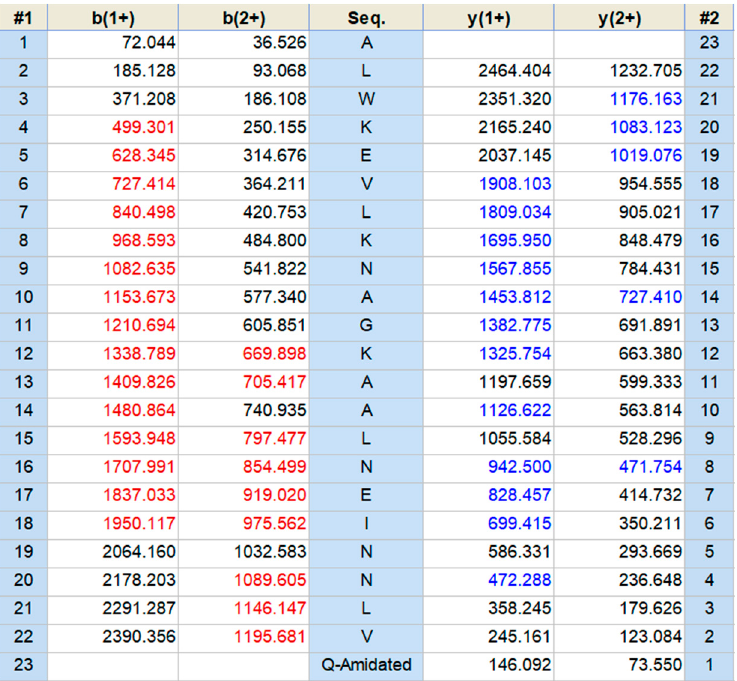
Figure 5. MS/MS fragmentation datasets derived from ions coincident with the mass of Dermaseptin-PH. Predicted singly and doubly charged b -ions and y -ions arising from MS/MS fragmentation of Dermaseptin-PH. Ions detected by MS/MS fragmentation are indicated in red and blue.